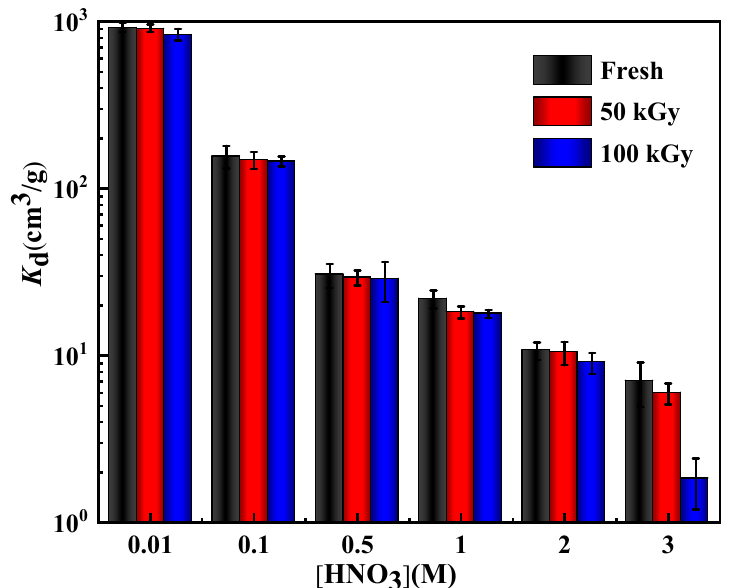
Figure 7. The effects of the γ -ray irradiation on different concentrations of nitric acid, with the following adsorption conditions: V / m = 100 cm 3 /g, [Re] =1 mM, T = 25 °C, and contact time = 12 h.